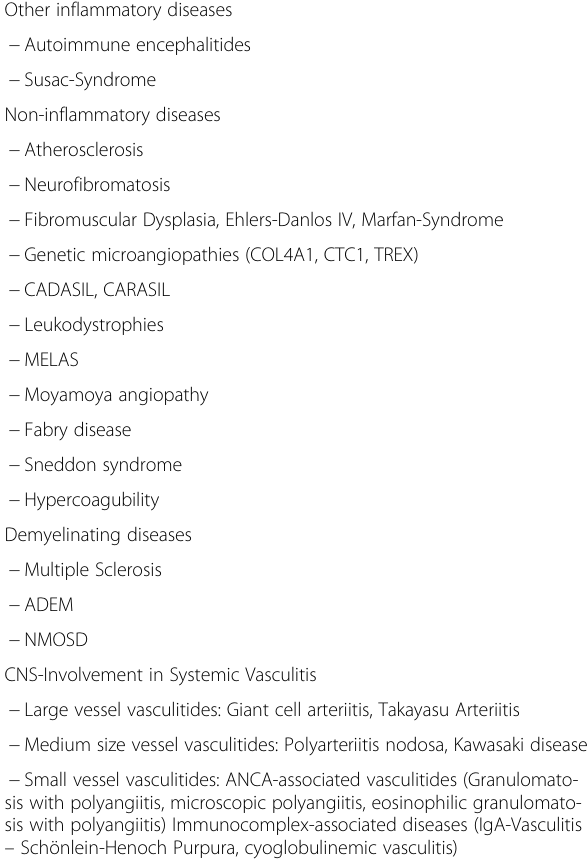
Table 2 Differential diagnoses of PACNS [6,